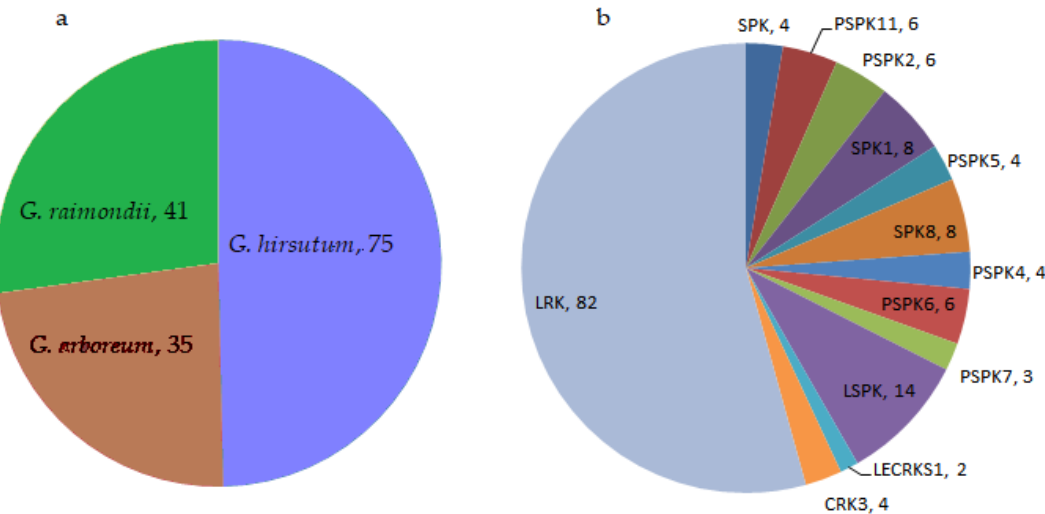
Figure 2. ( a ) Indicates the total number of Pkinase genes among the three cotton species and ( b ) indicates the number of genes in individual subfamilies of the Pkinase gene family.